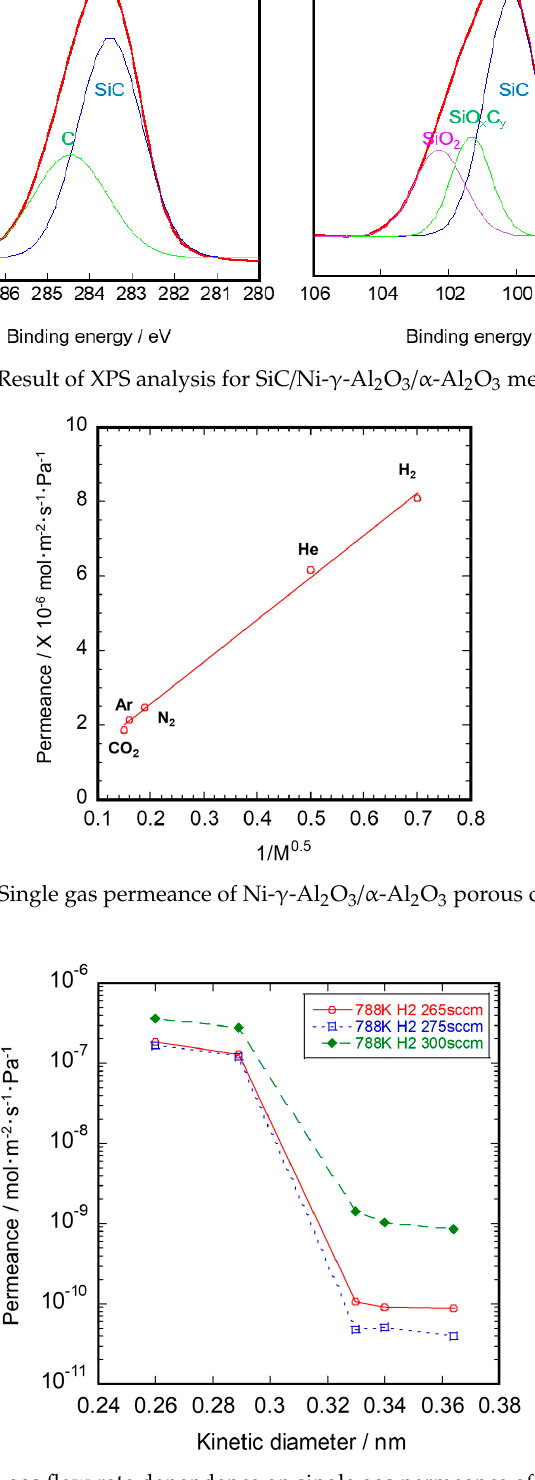
Figure 7. Result of XPS analysis for SiC/Ni- γ -Al 2 O 3 / α -Al 2 O 3 membrane.